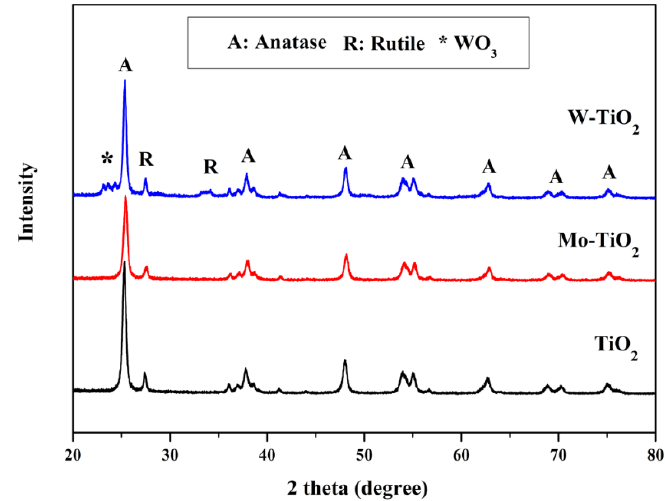
Figure 1. XRD patterns of Mo ‐ TiO 2 and W ‐ TiO 2 .